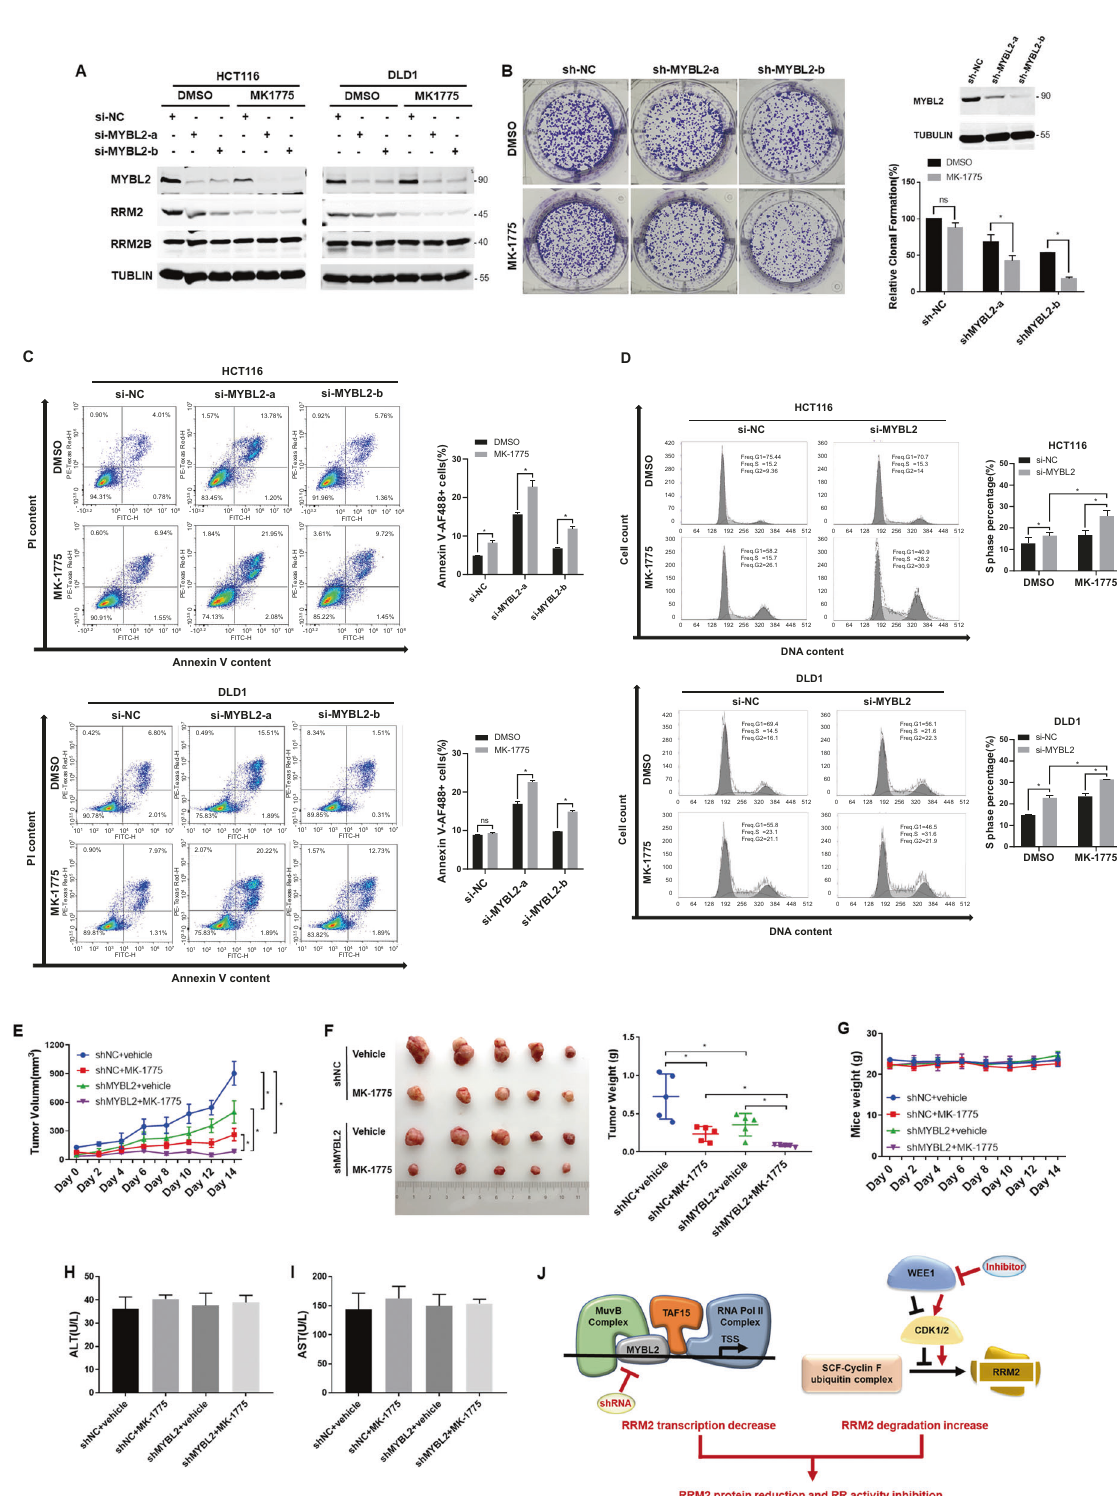
units/mL penicillin. CRC cell lines were identi fi ed by STR pro fi ling, and mycoplasmas were tested every six months. Cells were transfected with plasmids using X-tremeGENE HP DNA transfection reagent (Roche, USA) and transfected with siRNAs using Lipofectamine RNAiMAX Reagent (Invitrogen, USA) according to the manufacturers ’ instructions. To synchronize cell cycle, DLD1 cells were